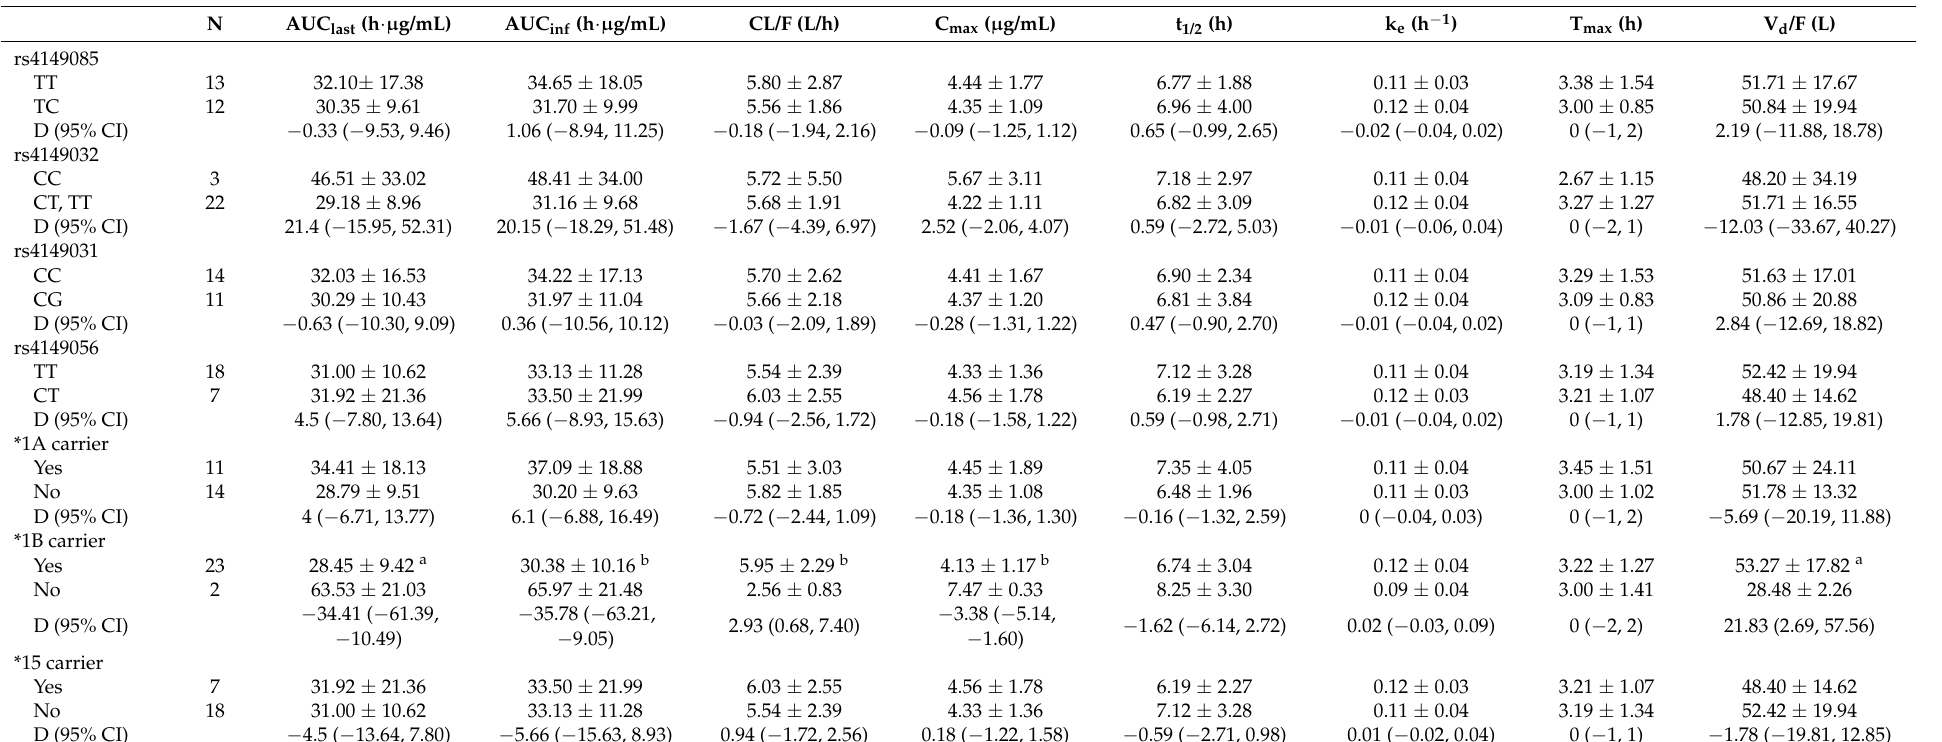
AUC last : area under the plasma concentration-time curve from time zero to the time of the last concentration, AUC inf : area under the plasma concentration-time curve from time zero to the infinity, CL: clearance, F: bioavailability, C max : maximum plasma concentration, t 1/2 : terminal half-life, k e : elimination rate constant, T max : time to maximum concentration, V d : volume of distribution, D: median difference, CI: confidence interval. *1B carrier: SLCO1B1 *1B (c.388G-c.521T). a p < 0.05, b p < 0.01 in Mann-Whitney U test between 2 genotype